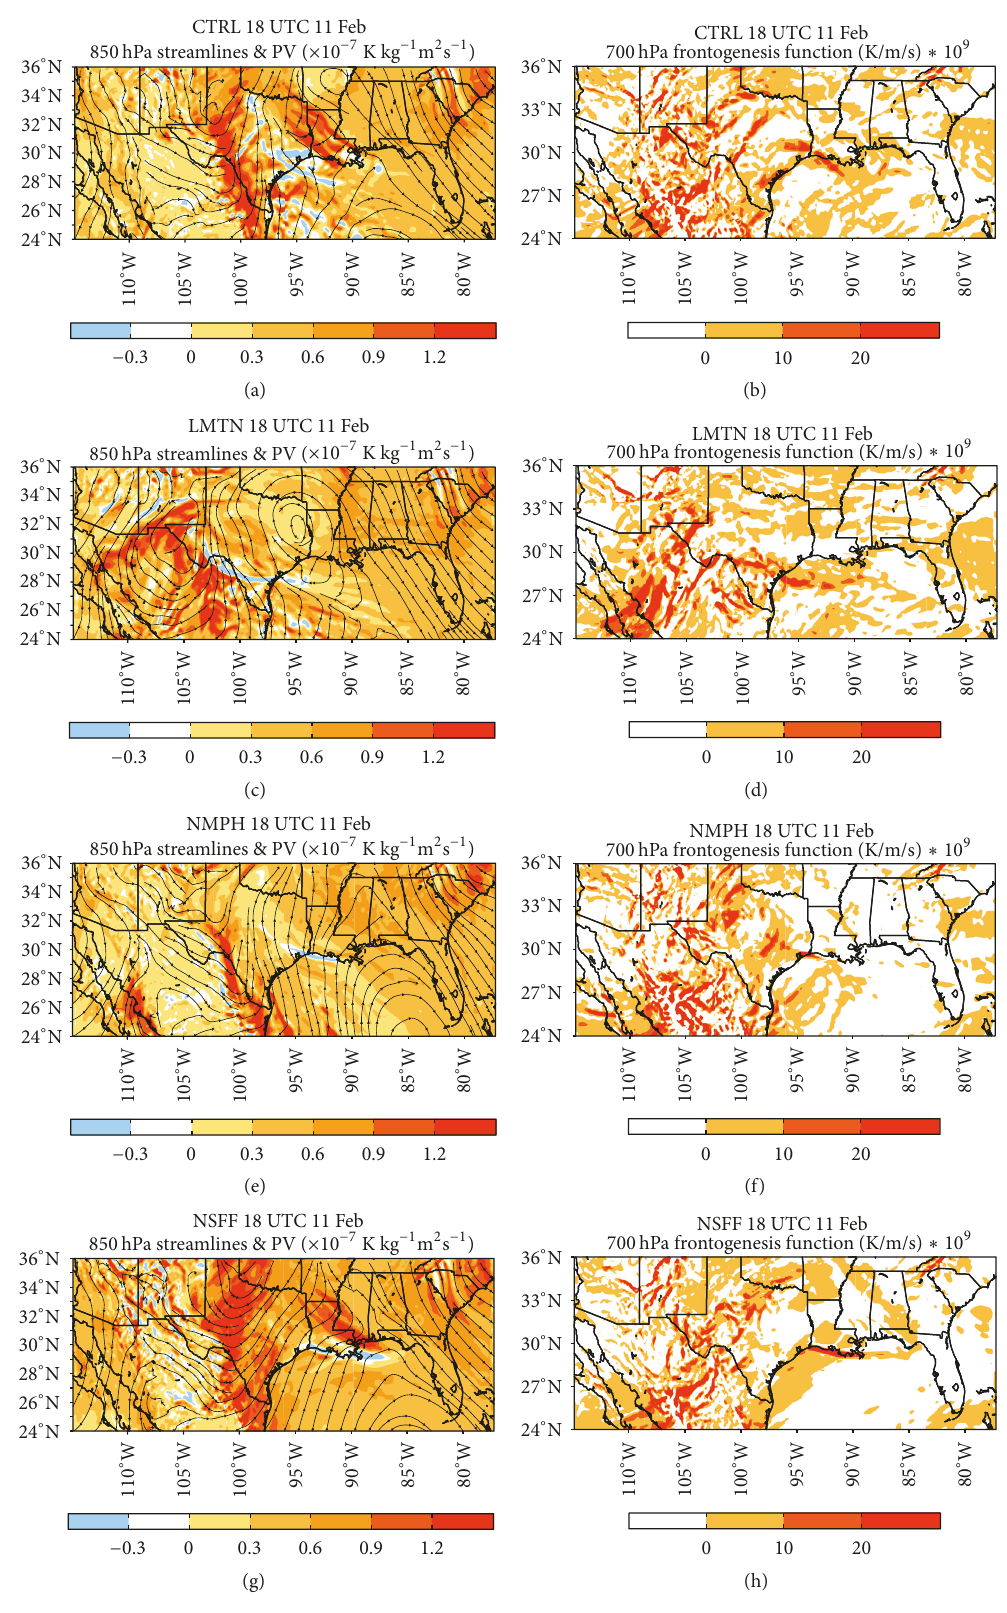
Figure 19: Simulated (12km) 850 hPa streamlines, potential vorticity, and 700 hPa frontogenesis on 1800 UTC 11 February 2010 for (a-b) control experiment, (c-d) terrain reduction experiment, (e-f) no microphysics heating experiment, and (g-h) no surface flux